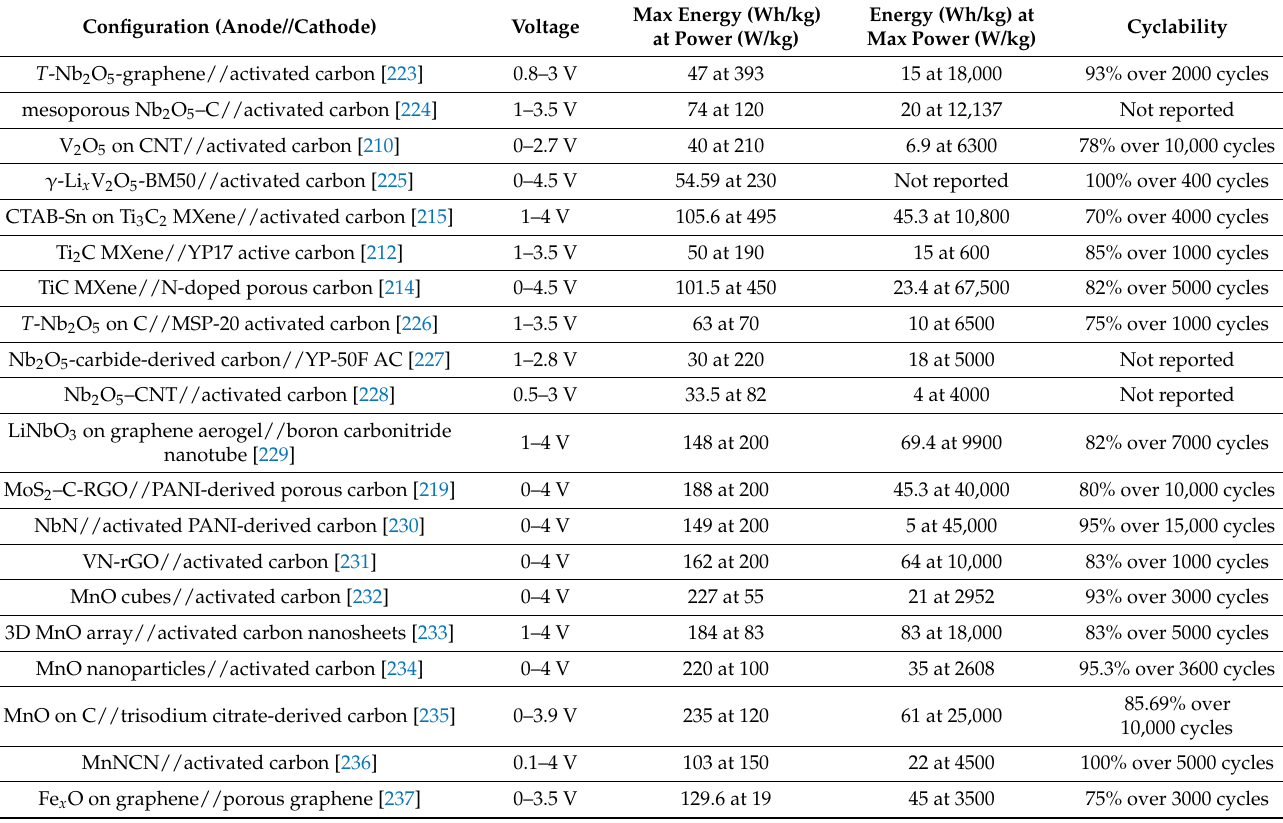
Table 3. Next-generation electrode materials for